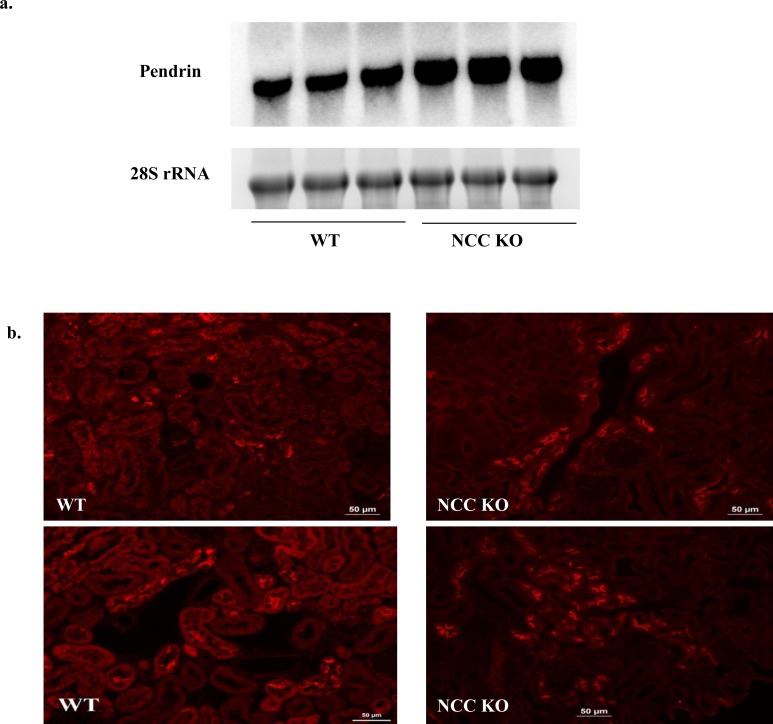
Expression of pendrin in kidneys of WT and NCC KO mice.Expression of pendrin by (a) Northern hybridization and (b) Immunofluorescence labeling in kidneys of WT and NCC KO mice. Northern hybridizations showed significant increase in pendrin expression in NCC KO mice vs. WT littermates (with expression of pendrin increasing by 130% vs. wt littermates, p<0.03). Immunofluorescence labeling showed significant increase in the number of pendrin positive cells in kidneys of NCC KO mice vs. WT littermates (p<0.01 vs. WT).